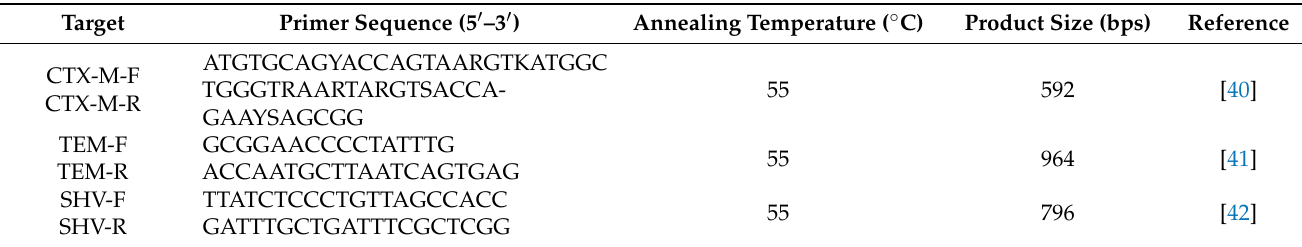
Table 1. β -lactamase genes